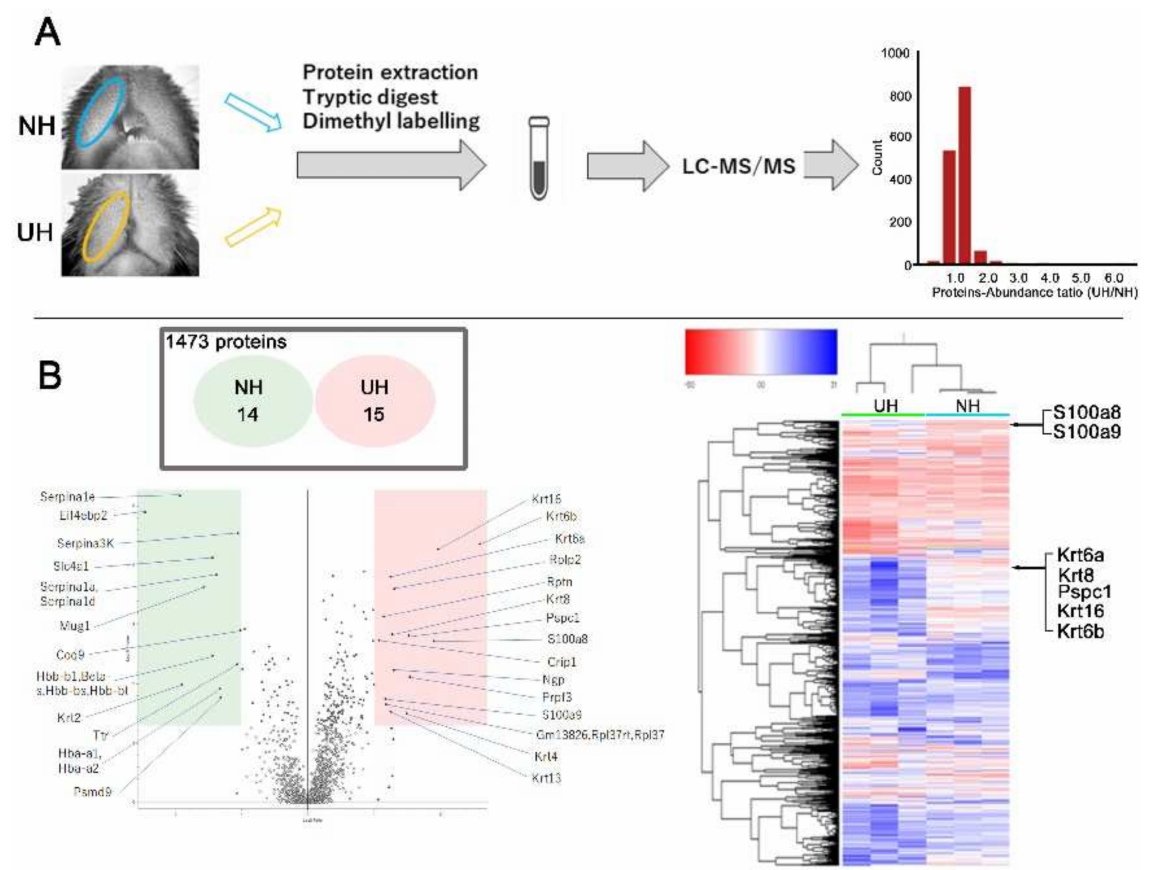
Figure 4. ( A ) Experimental procedure for the proteomic investigation. Histogram of protein counts grouped according to log2 protein ratios. In total, 1473 proteins were detected in the two groups using high-sensitivity liquid chromatography–tandem mass spectrometry. ( B ) Volcano plot of the statistical significance of differences (Student’s t -test p -value) as a function of the average protein ratios. Fifteen proteins were enriched in UH mouse lips (orange), while 14 were enriched in NH mouse lips (green). Heatmap illustrating quantitative alterations of representative proteins. Enrichment of S100a8, S100a9, keratin 6a (KRT6a), keratin 6b (KRT6b), keratin 8 (KRT8), and keratin 16 (KRT16) expression was detected in UH mouse